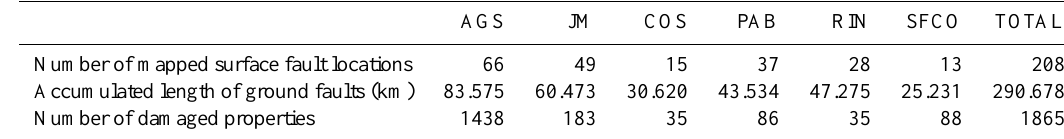
Table 1. Ground faults length in municipalities and number of affected properties. AGS: Aguascalientes, JM: Jesús María, COS: Cosio, PAB: Pabellón, RIN: Rincón de Romos, SFCO: San Fancisco de los Romo.